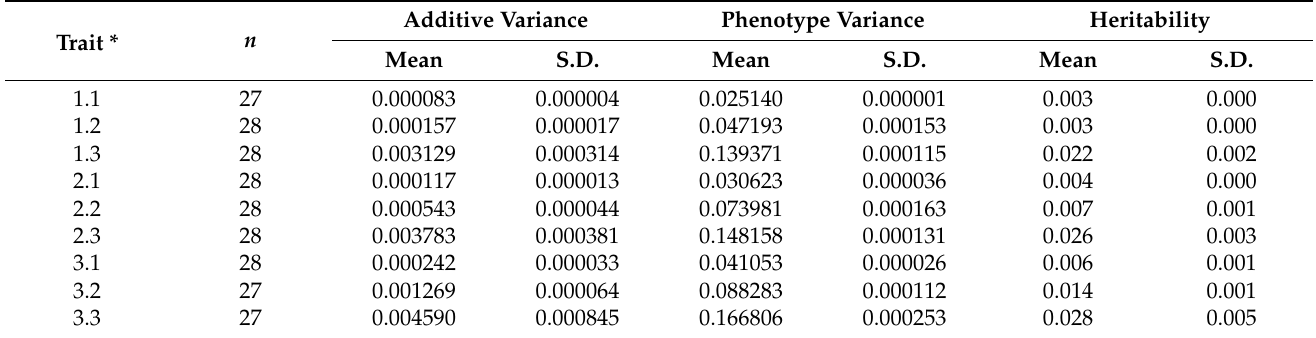
Table 1. Additive variance, phenotype variance, heritability, and number of contributing runs ( n ).